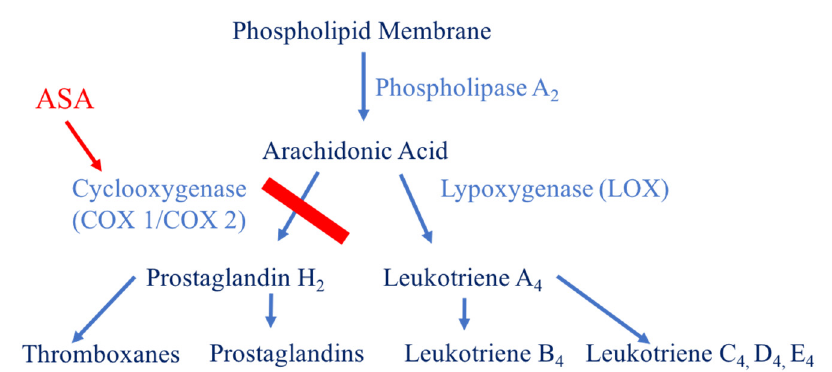
Figure 7. Mechanism of action of aspirin (ASA). The binding of aspirin to COX-1 or COX-2 prevents the formation of prostaglandin H2 and subsequently thromboxane and prostaglandin, affecting platelet aggregation.